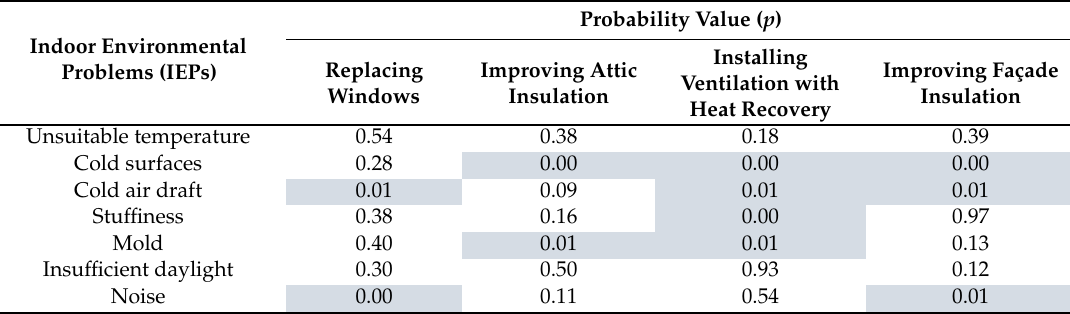
Table 4. Influence of indoor environmental problems on the interest to adopt